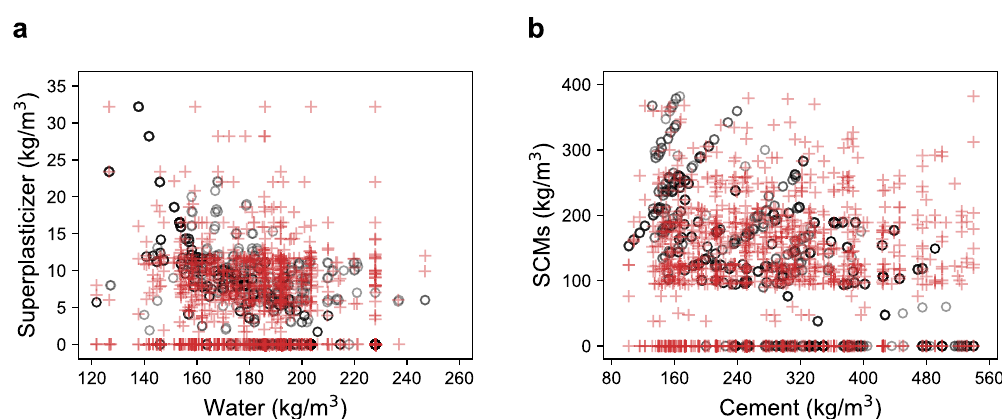
Fig. 7 Illustration of unrealistic concrete mixtures generated by permutation feature importance method. Data were obtained from the concrete compressive strength dataset available in the UC Irvine Machine Learning Repository 24,112 (Table 2). a , b The variable for water ( a ) or cement ( b ) was randomly shuf fl ed while keeping other variables constant. The black circles refer to the observed mixtures, the red pluses to the generated mixtures after shuf fl ing, and their transparency represents the frequency. SCMs, supplementary cementitious